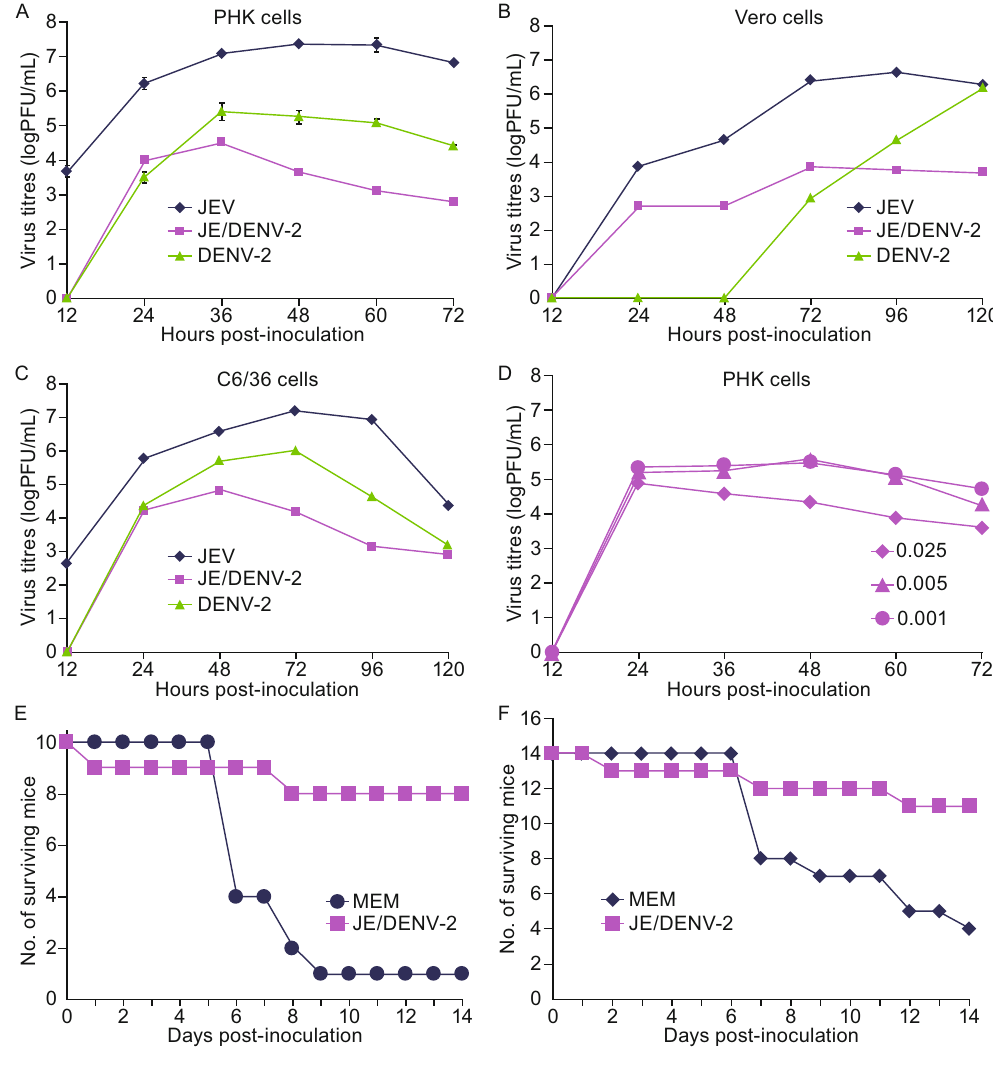
Figure 2. The growth curve of the chimeric virus in PHK, Vero and C6/36 cells and the chimeric virus JE/DENV-2 confers protection against neuroadapted DENV-2 virus (New Guinea strain, NGC) and JE virulent virus JEV/SA14 . The growth curve of DENV-2, JE/DENV-2 and JEV in PHK cells (A), Vero cells (B), C6/36 cells (C) and PHK cells (D) (different M.O.I.). Mice were immunized with JE/DENV-2 via the i.p. route, or mock immunized (MEM). One month after immunization, mice were challenged via the i.c. route with neuroadapted DENV-2 NGC strain virus (shown in E) or via i.p. inoculation with JEV/SA14 virus (shown in F). The number of survived mice at each time point was recorded and plotted. M.O.I., multiplicity of infection; MEM, minimum essential medium; PHK, primary